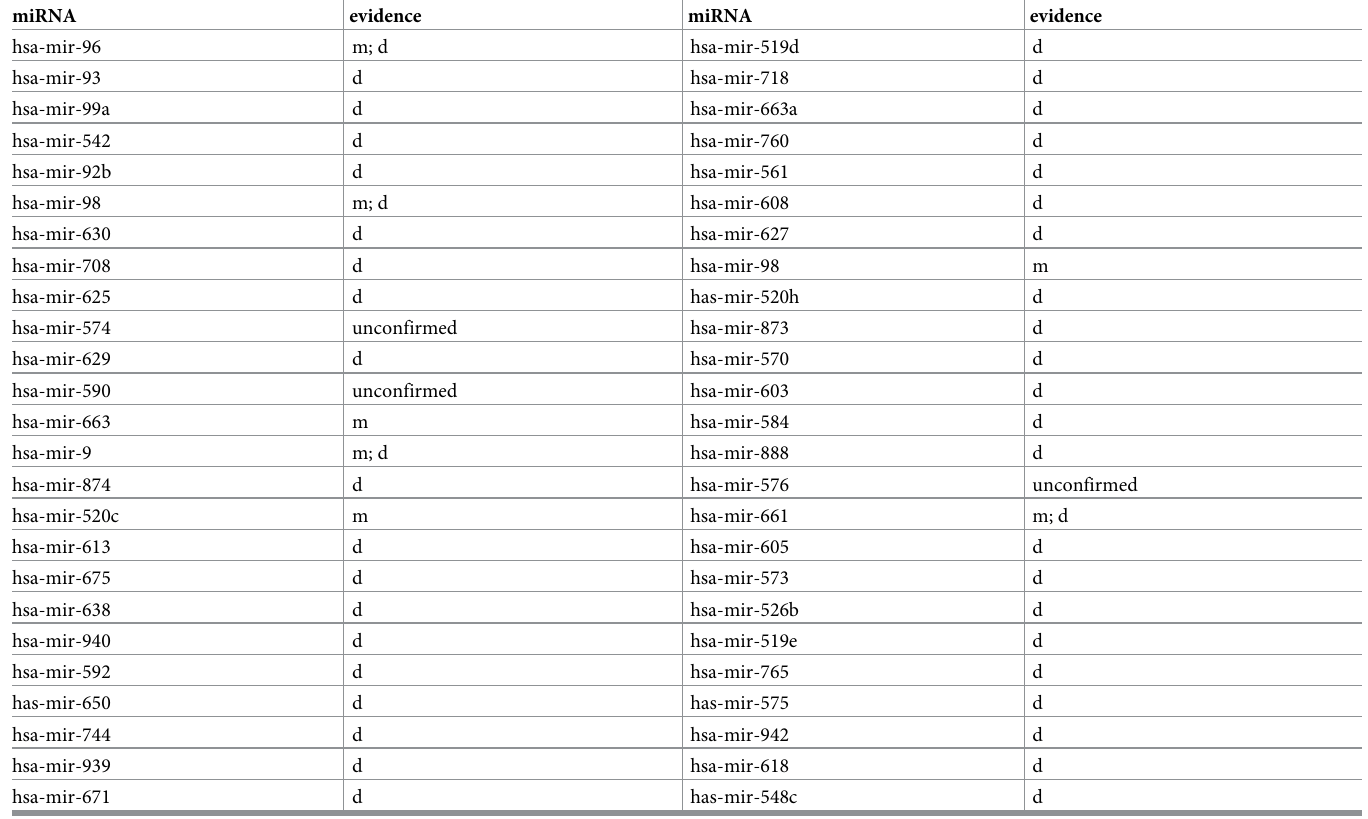
Table 2. The top 50 potential miRNAs associated with breast neoplasms. miRNA